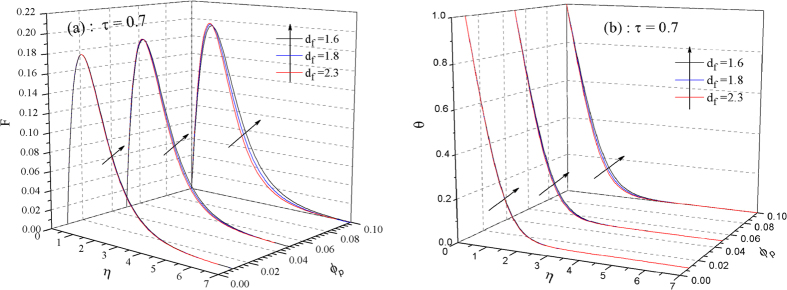
Volume fraction and fractal dimensions dependence of thermal convection.Synergistic effects of primary volume fraction of nanoparticles ϕp and fractal dimensions df on dimesionless velocity in (a) and temperature distributions in (b), respectively. The visible effects of df appear for concentrated nanofluid 0.05 ≤ ϕp ≤ 0.1, but negligible effects for dilute nanofluid 0.01 ≤ ϕp < 0.05.